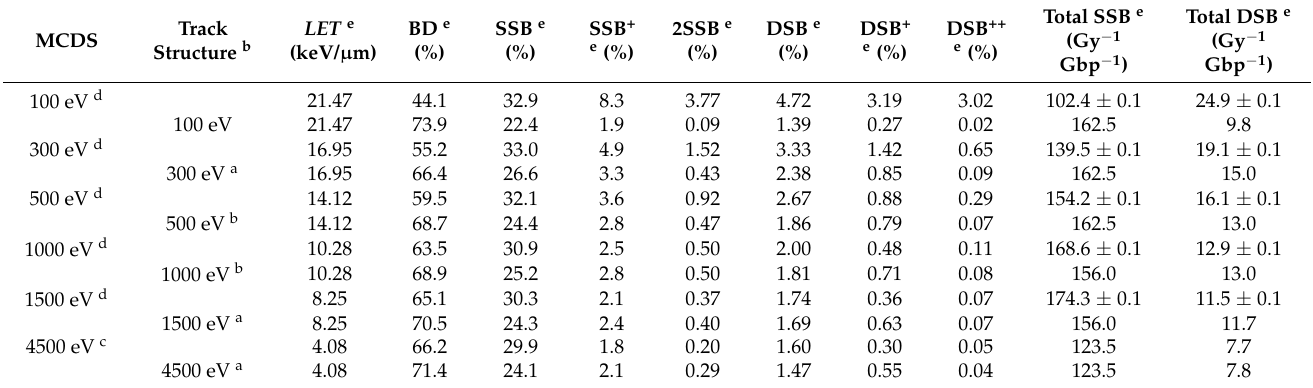
Table 1. Comparison MCDS results (mean ± standard error) for monoenergetic electrons and those obtained by track structure